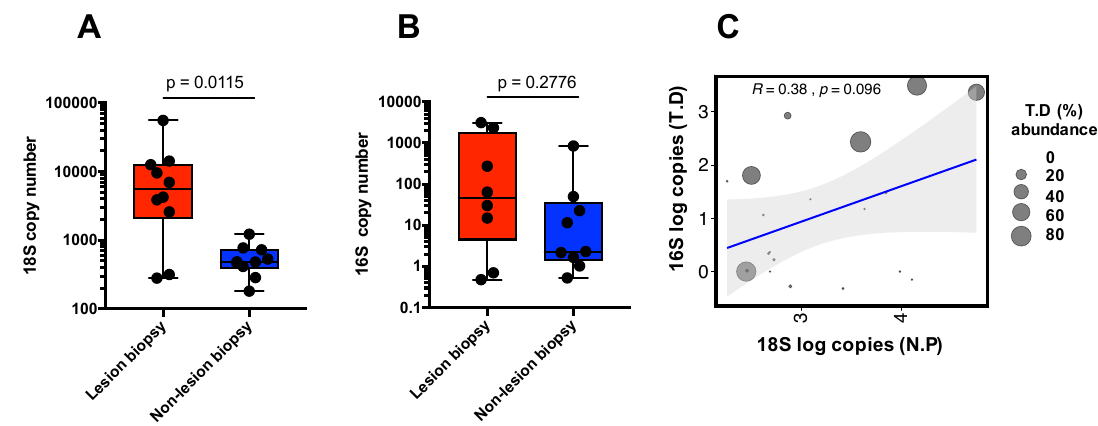
Figure 7. ( A )—18S gene copy number, and ( B )—16S gene copy number ( B ) for both N. perurans and T.dicentrarchi qPCRassaysrespectively, comparingLBandNLBsamplegroups( p value =